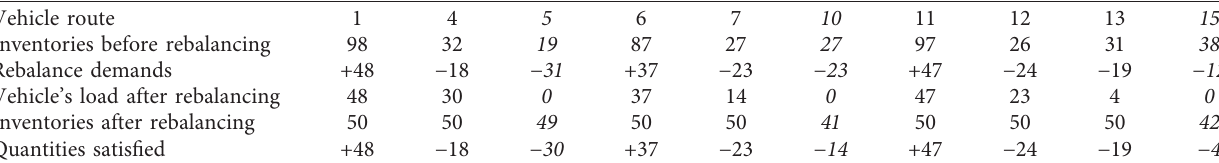
Table 3: An example of the initial